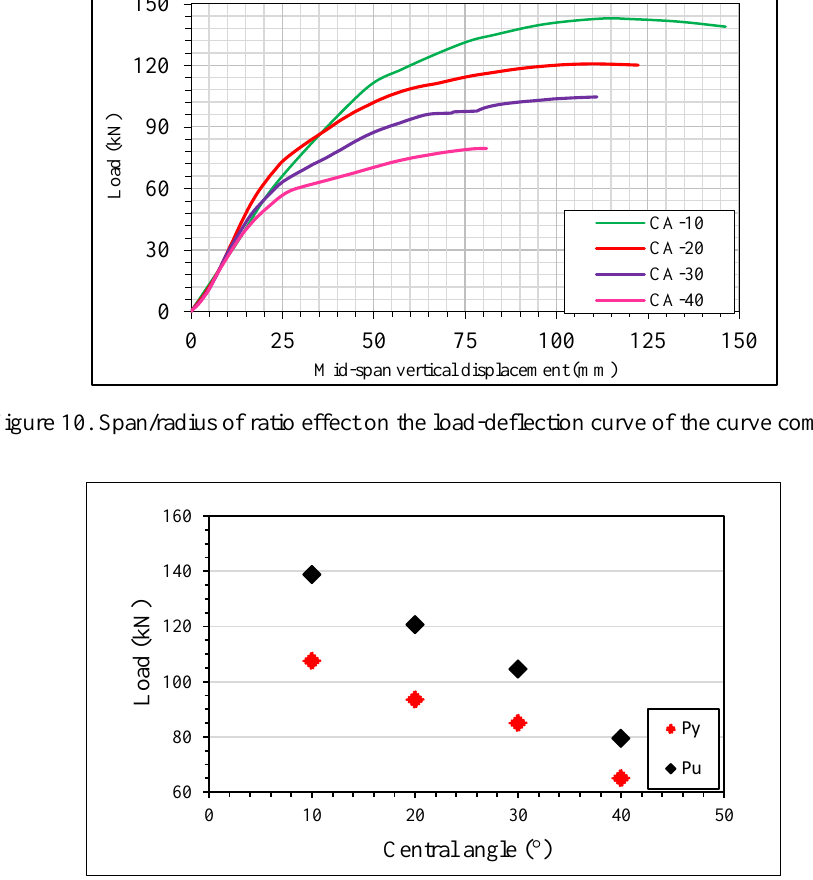
Figure 11. Yield, ultimate load-central angle relationship